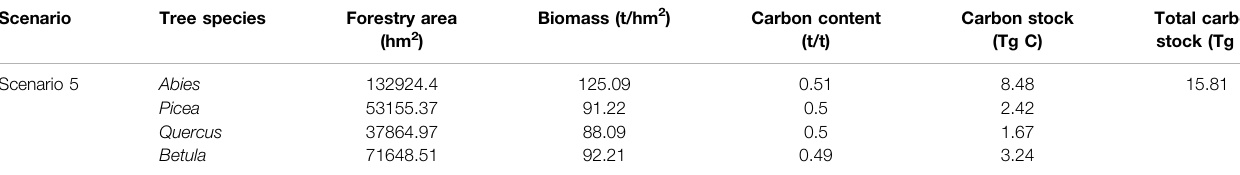
TABLE 5 | Carbon stock of the optimal scenario.